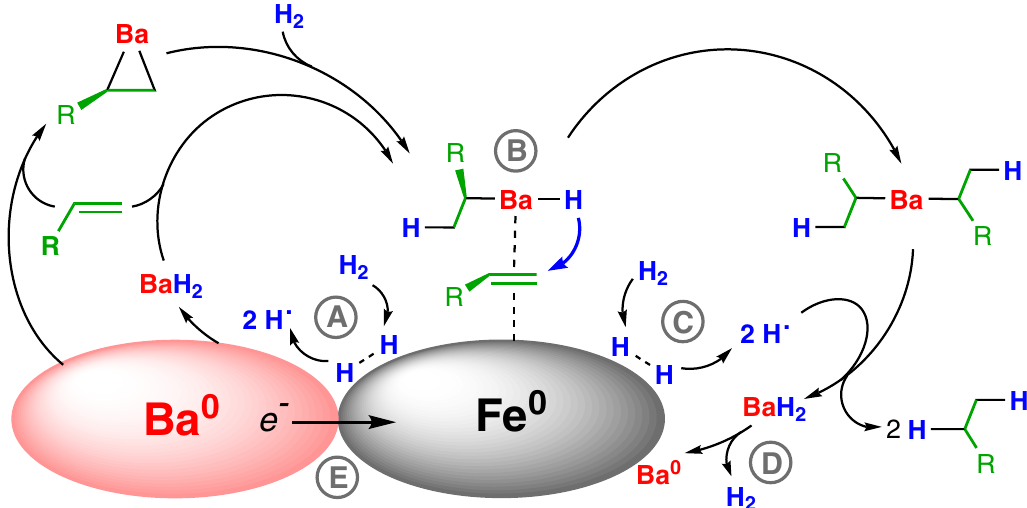
Fig. 6 Synergy between Ba 0 and Fe 0 in catalytic alkene hydrogenation. The Ba component enters the solution phase by reaction of electropositive Ba 0 with H 2 or alkene. The following steps are potentially supported by the heterogeneous Fe 0 component: (A) Fe 0 facilitates H-H bond cleavage and BaH 2 formation. (B) Alkene activation by Fe( d ) → π *(alkene) backdonation. (C) Hydrogenolysis of alkylbarium intermediates is facilitated by the presence of H radicals. (D) Fe 0 catalyzes the desorption of H 2 from BaH 2 . (E) Ba-Promotion of Fe 0 by electron